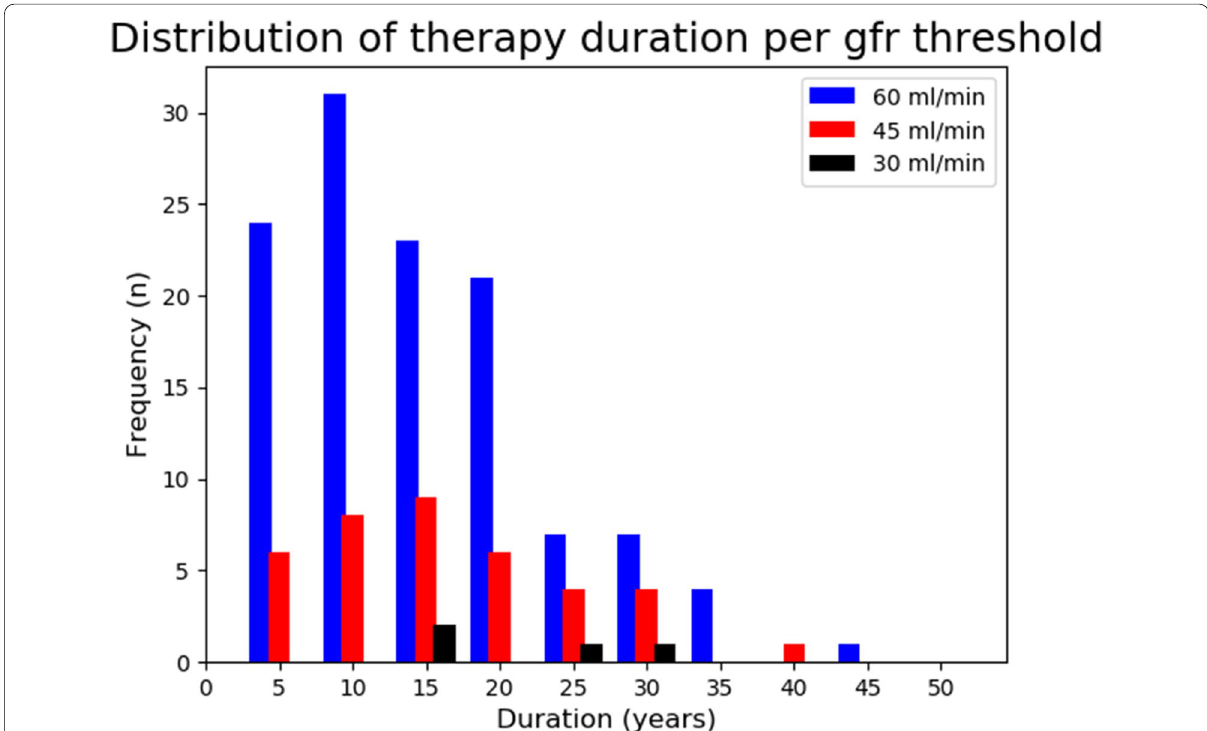
Fig. 2 Distribution of therapy duration per GFR